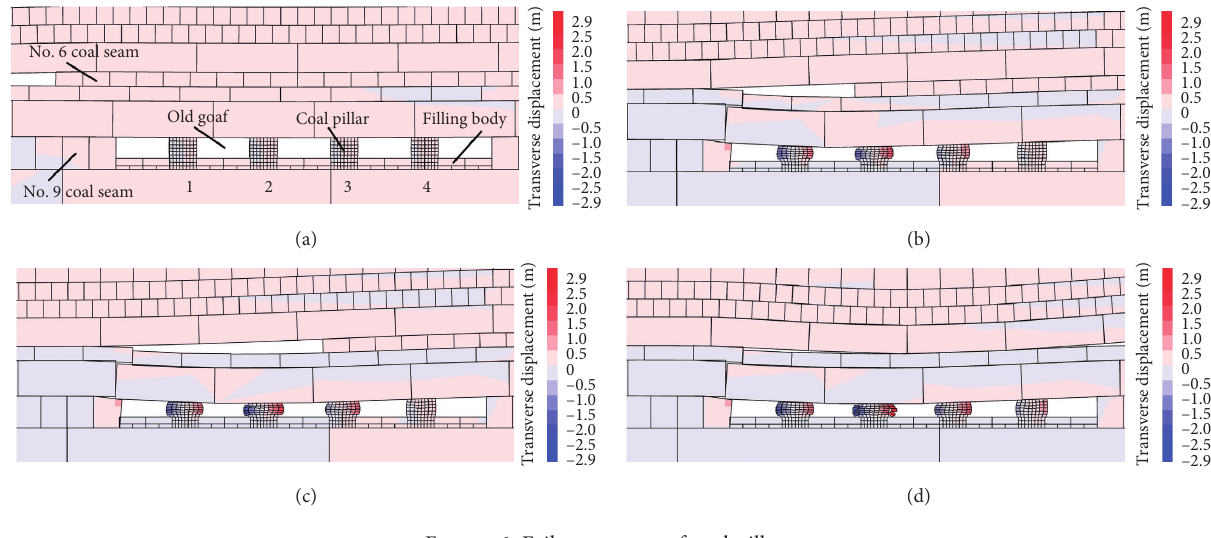
Figure 6: Failure process of coal